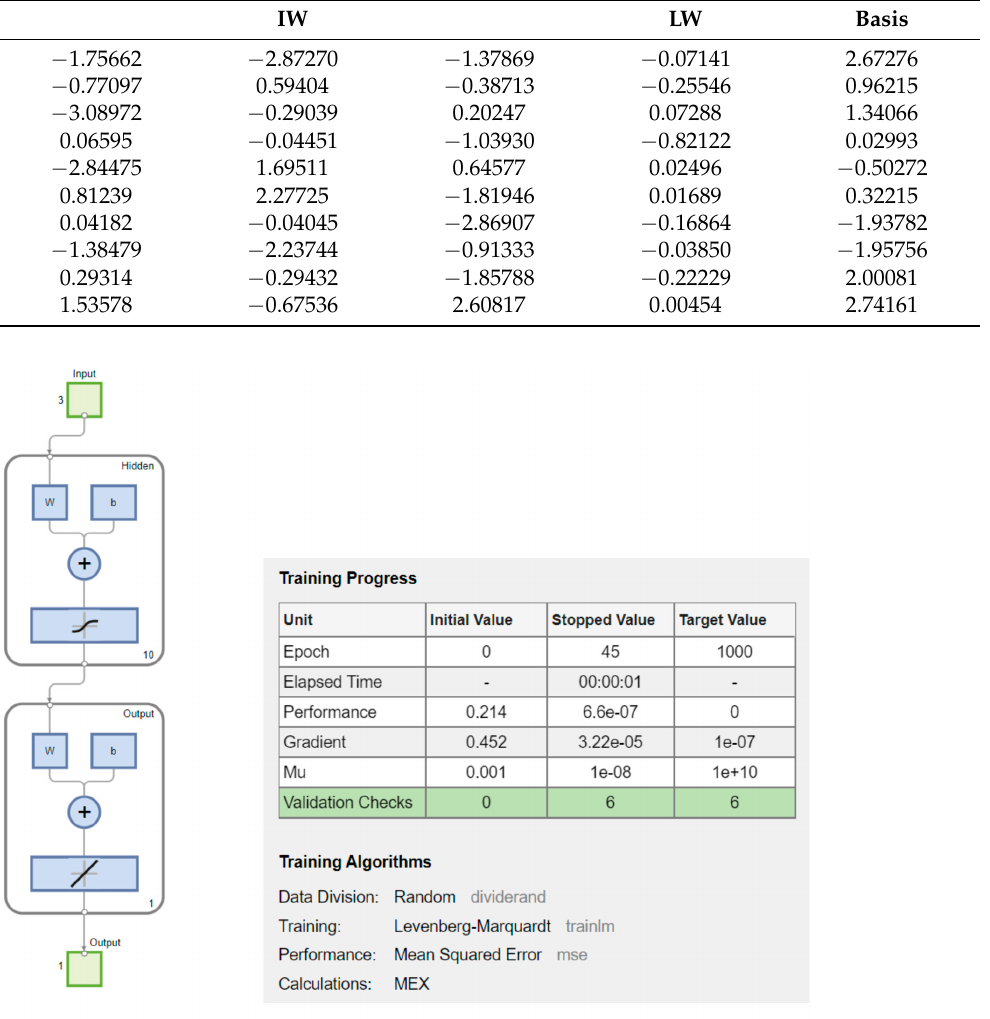
Figure 13. The performance curves during the training process. Epoch 39 provided the best valida- tion performance and was selected for simulations.